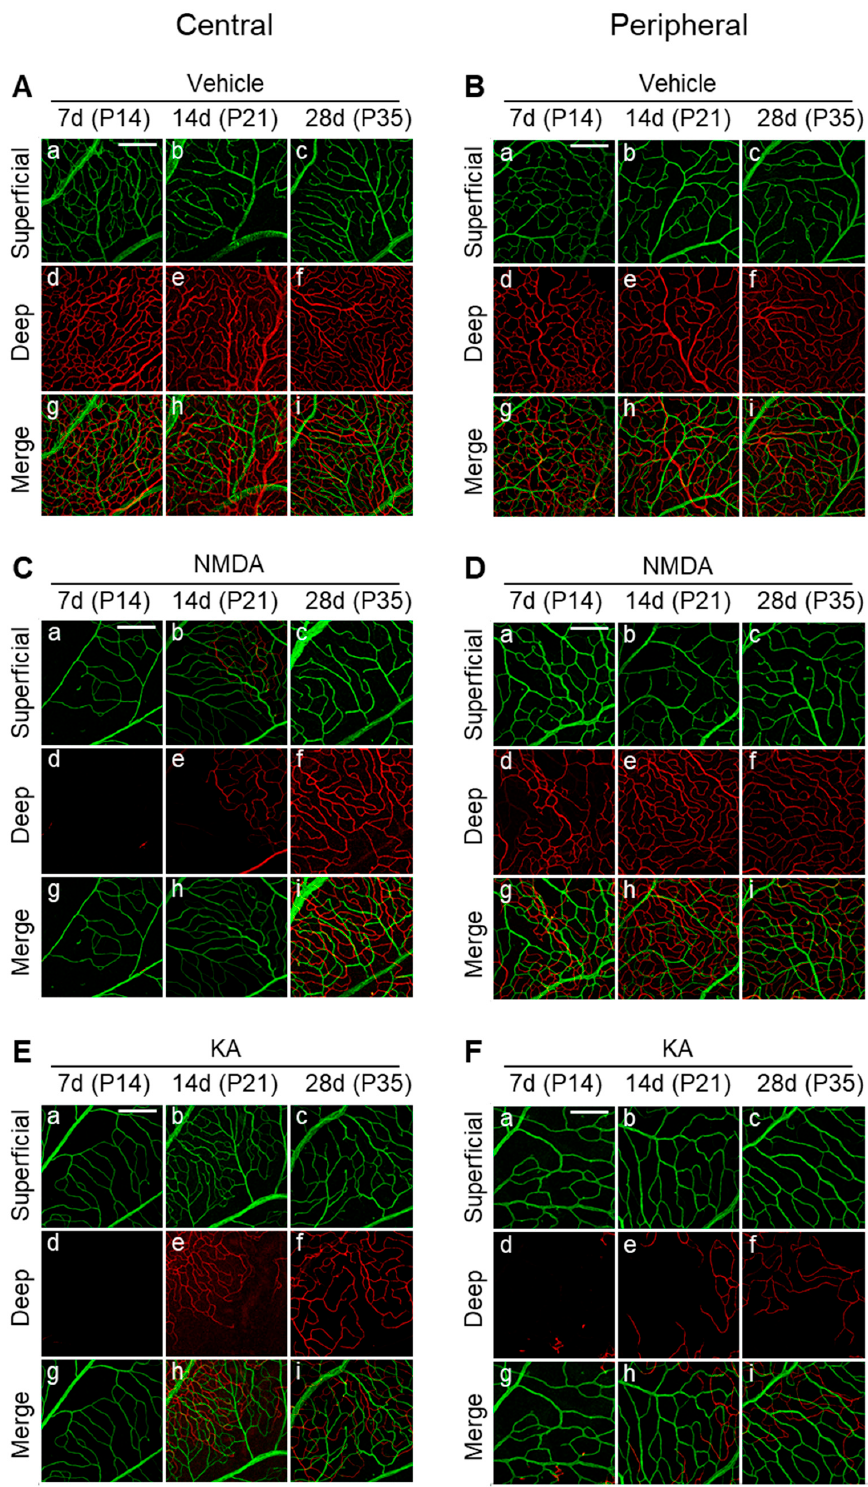
Figure 3. Formation of retinal superficial and deep vascular plexuses in rats intravitreally injected with vehicle, NMDA, or KA. Confocal microscopy images of retinal whole-mounts stained with an endothelial cell marker (RECA). Color depth projections show the vascular plexuses at the central and peripheral retinal areas as a single projection, in which distinct depth levels are color-coded. Superficial and deep blood vessels are indicated by green and red, respectively. ( A , B ) Vehicle; ( C , D ) NMDA; ( E , F ) KA. Scale bar = 150 µ m in a (applies to